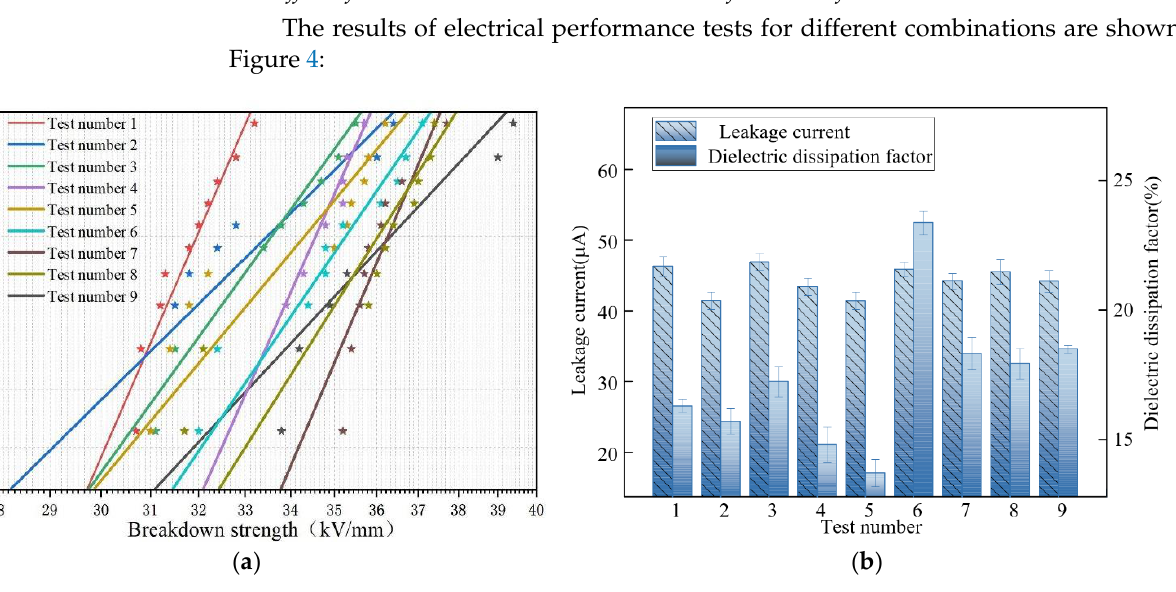
Figure 4. Electrical properties of different groups of PU-ER: ( a ) Breakdown strength; ( b ) Leakage current and dielectric loss factor.